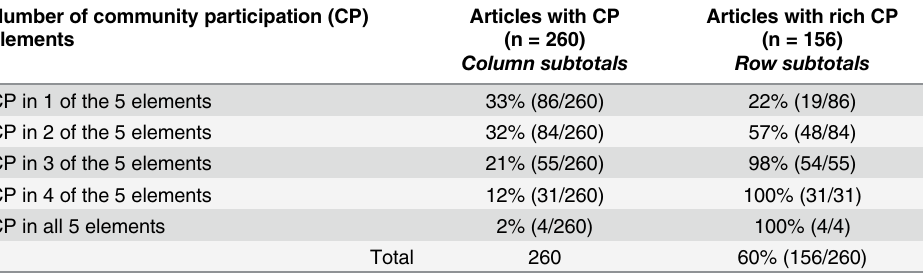
Table 6. Number of elements of community participation.